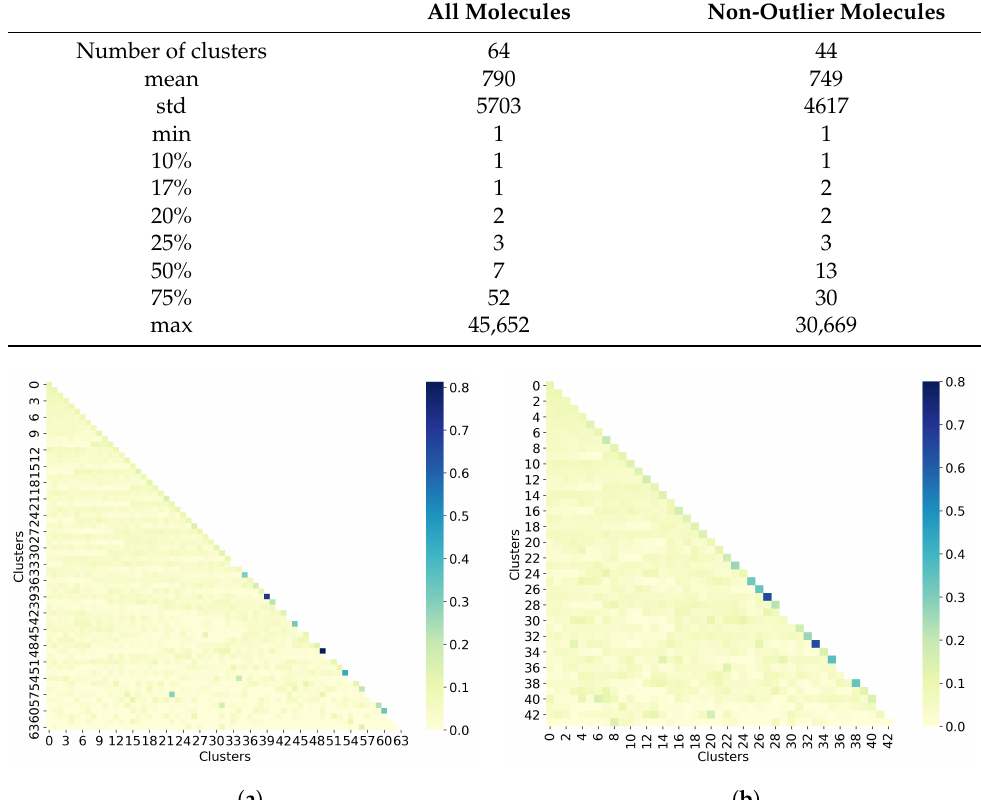
Table 4. Descriptive statistics of the cluster sizes obtained by the Taylor–Butina algorithm. This al- gorithm was applied to all molecules and non-outlier molecules, showing that singletons were obtained in both cases. The similarity cutoff used to obtain the clusters in Taylor–Butina was set to 0.9 (see Table 3 for more details about the similarity cutoff selected). Non-outlier molecules were retrieved at an outlier cutoff of 0.5.